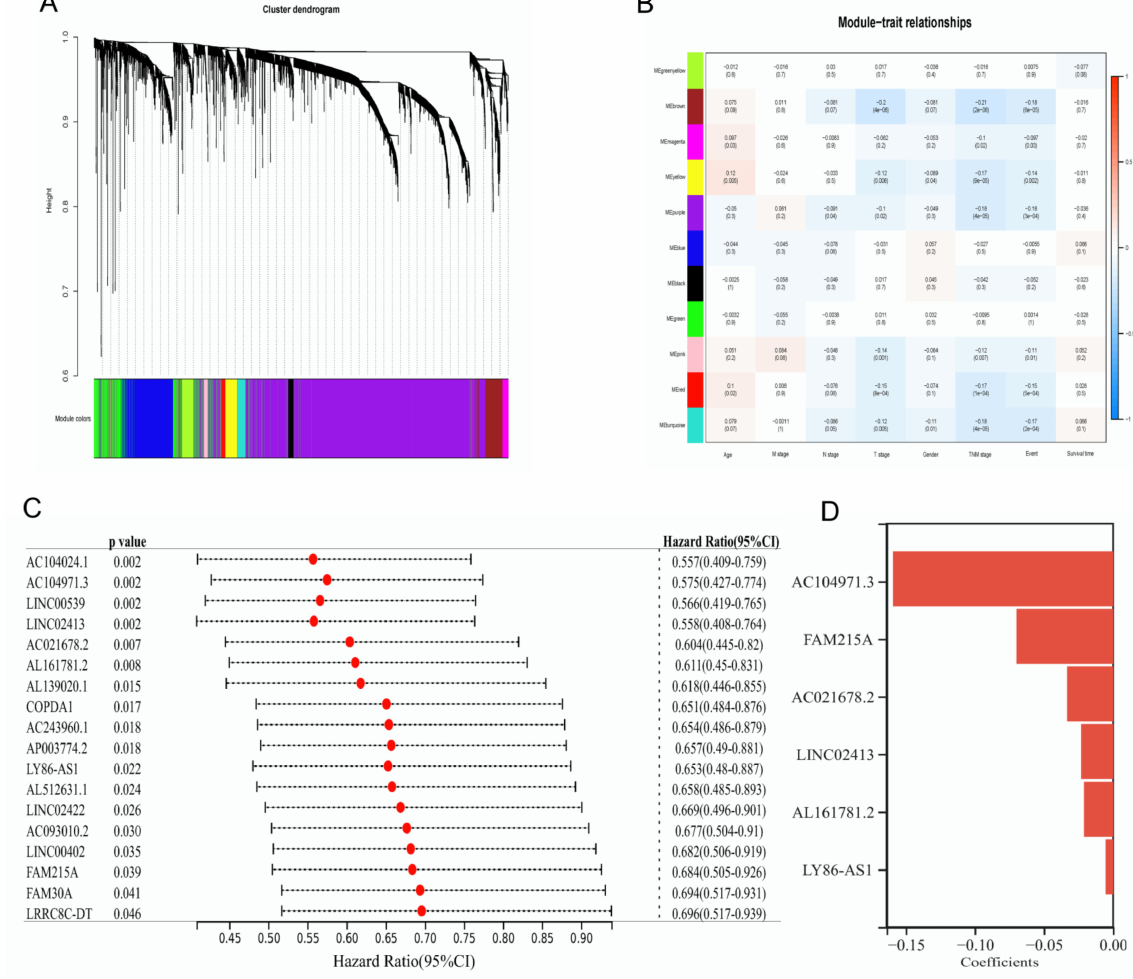
Figure 1. Six identified immune-related lncRNAs (IRLs) after weighted gene coexpression network analysis (WGCNA) and regression analyses. ( A ) Hierarchical clustering tree on IRL’s coexpression network. ( B ) A heatmap of modules and clinical traits, including age, M stage, N stage, T stage, gender, TNM stage, clinical event, and survival time. The numbers in each box and parenthesis represented correlation coefficient and p value. ( C ) Eighteen prognosis-related IRLs screened by univariate Cox regression. ( D ) Coefficients of six prognostic IRLs identified by the Lasso